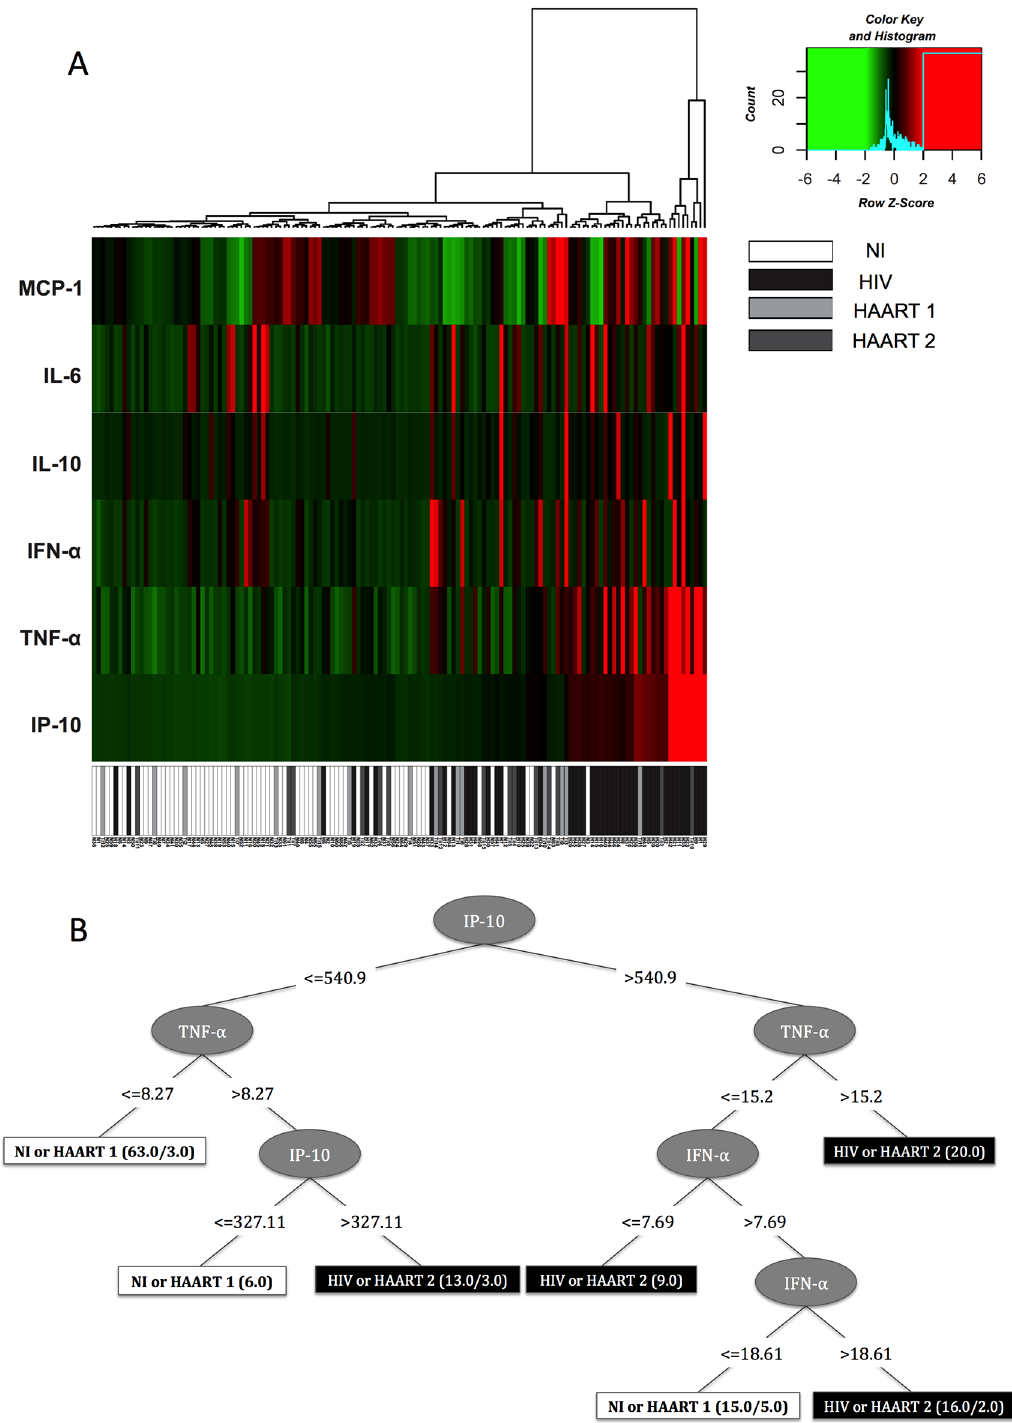
Fig 5. The expression pattern of the main immunological biomarkers defines a segregation profile upon infection and between different treated HIV groups. A) The values of IP-10, IL-6, TNF- α , IFN- α , IL-10, and MCP-1 were used to calculate the Z-score for each cytokine produced by subjects individually, for further generation of a heat map. Row Z-score scaled from -6 to +6 and is illustrated as green, black, and red colors. B) The values of IP-10, IL-6, TNF- α , IFN- α , IL-10, and MCP-1 were used for the decision tree dataset construction. The decision tree was generated considering the clustering of NI and HAART 1 as one group, and HAART2 and HIV as another. The numbers beside the group names indicate the correct/incorrect ranking of the